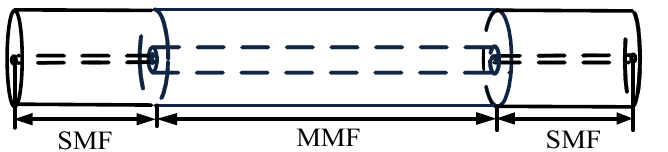
Figure 1. Schematic diagram of the Single mode–Multimode–Single mode Mach–Zehnder Interfer- ometer (SMS MZI).